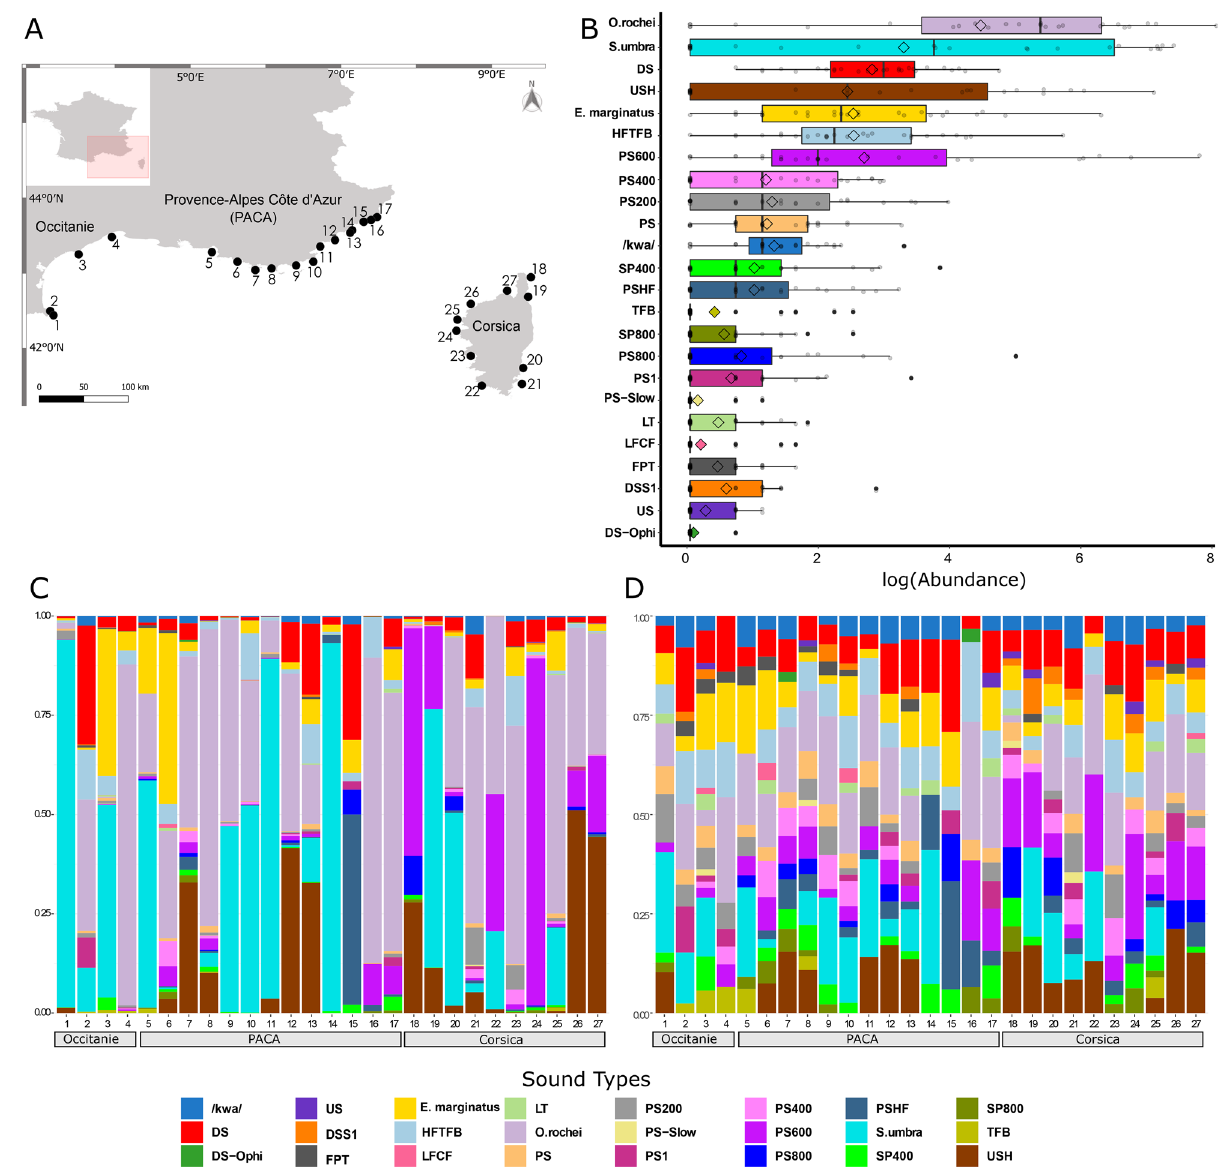
Figure 1. Biogeography of the acoustic biodiversity of coralligenous fish sounds. ( A ) Map of the 27 sampling sites of the CALME network across three areas of the north-western Mediterranean. Numbers indicate sites as listed in Supplementary Table S1. ( B ) Distribution of the total log relative abundance of each sound type (c.f. Supplementary Table S2) from all stations with the more abundant sound types on the top and the less abundant on the bottom. In each boxplot graph, diamonds indicate mean values (all stations) and grey dots indicate single values recorded from each station. ( C ) Bar chart showing the acoustic diversity of each site in different geographic regions based on the identified sound types (indicated by different colours) and their proportions of relative abundances. ( D ) Acoustic diversity of each site per geographic region based on the identified sound types (indicated by different colours) and the log of their occurrences to reduce the weight of abundant sounds and highlight “rare” sound types. Map 1A was created using QGIS.org, 2021. QGIS Geographic Information System. QGIS Association. http:// www. qgis.